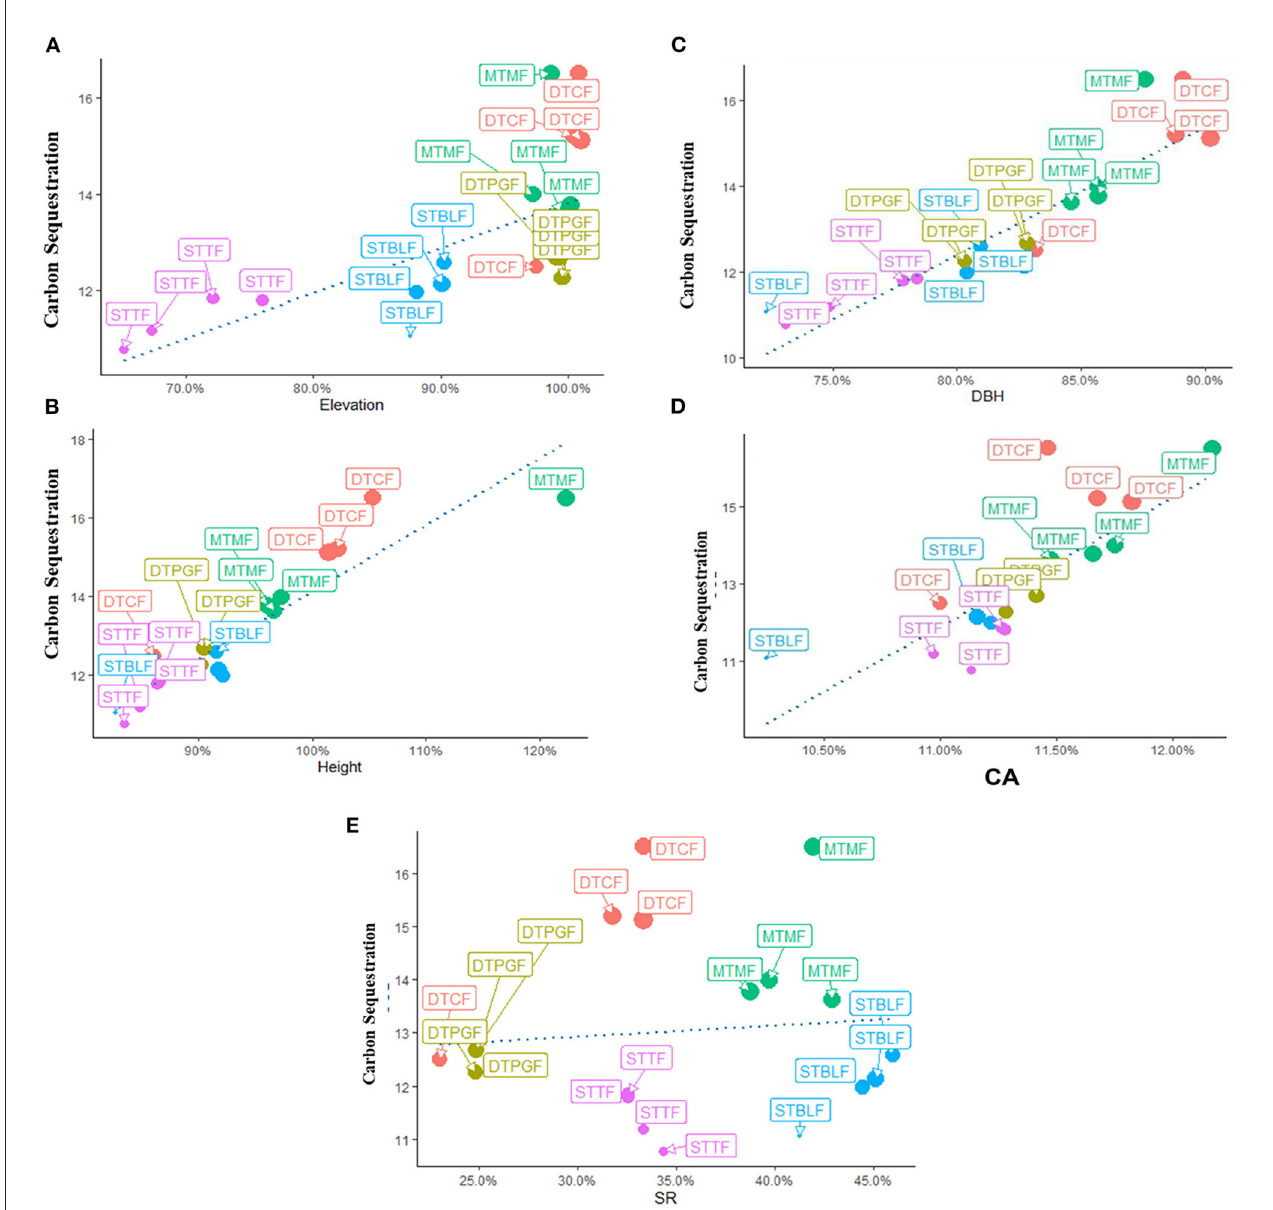
FIGURE5 Correlation between the dependent and independent variables, i.e., (A) Carbon sequestration with elevation, (B) Carbon sequestration with H, (C) Carbon sequestration with DBH, (D) Carbon sequestration with CA, (E) Carbon sequestration with SR. STTF, Sub-tropical thorn forests; STBLF, Sub-tropical broad-leaved forests; MTMF, Moist temperate mix forests; DTCF, Dry temperate conifer forests; DTPGF, Dry temperate Pinus gerardiana ( Chilgoza)